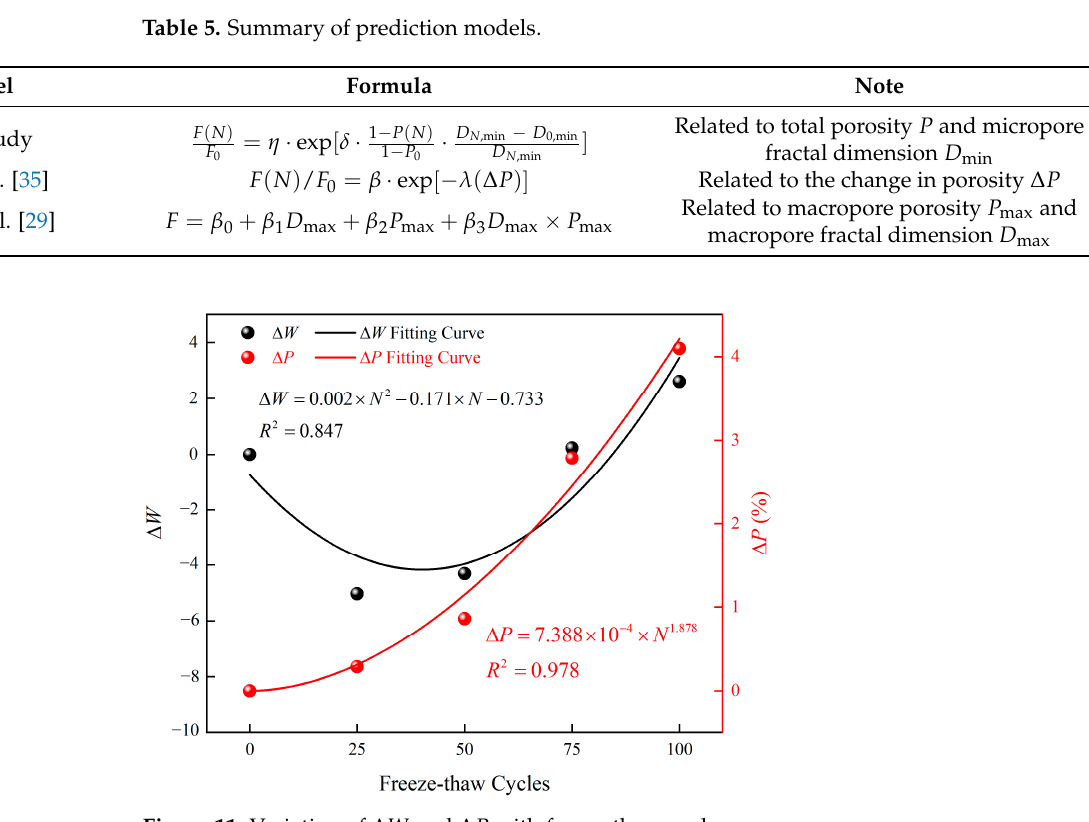
Figure 11. Variation of ∆ W and ∆ P with freeze-thaw